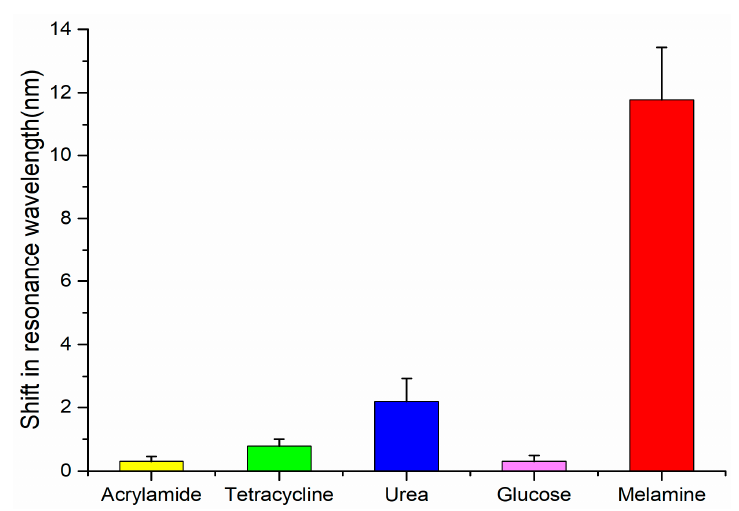
Figure 8. Specificity test of PoAP–MEL film. Resonance wavelength shift for the detection of acrylamide, tetracycline, urea, glucose and melamine solution with concentration ranging from 0 M to 10 − 7 M.